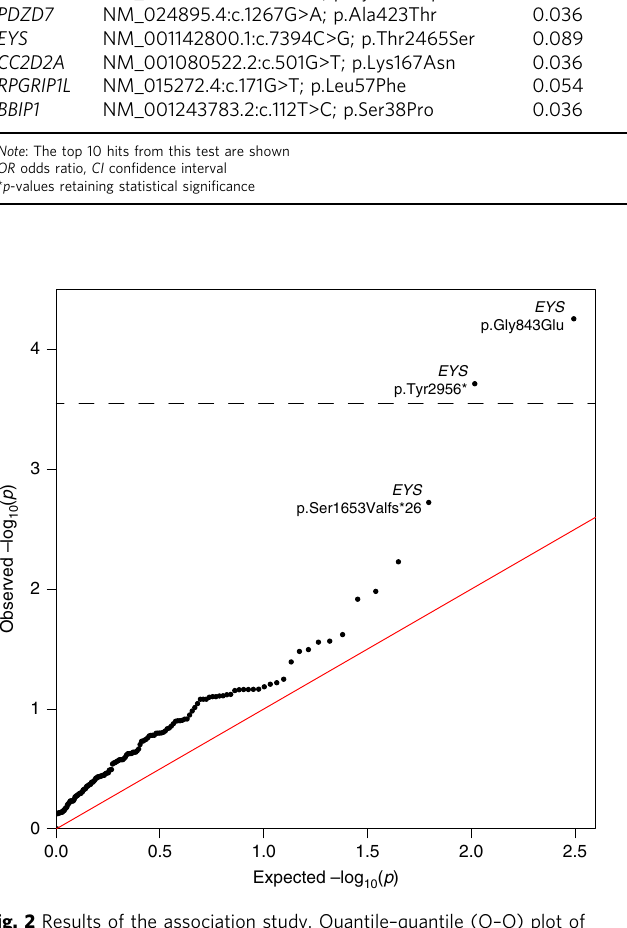
Fig. 2 Results of the association study. Quantile – quantile (Q – Q) plot of rare/low-frequency non-synonymous variants in HRD genes in 28 patients heterozygous for rs118031911/T vs. 3554 Japanese controls. The signi fi cance threshold is indicated by the dotted